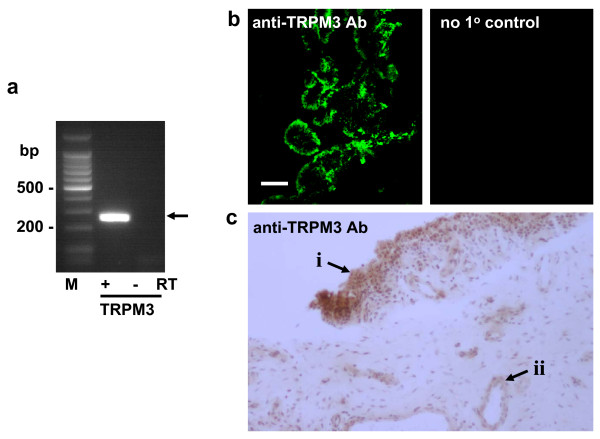
Expression of TRPM3 in FLSs of synovium in rheumatoid arthritis. (a) PCR products from analysis of mRNA isolated from primary cultured FLSs from patients with (+) and without (-) prior reaction with reverse transcriptase (RT). On the left is the DNA marker ladder (M). The expected TRPM3 mRNA product size is indicated with an arrow. (b) Serial sections of RA synovial biopsy labeled with the primary (1°) anti-TRPM3 antiserum present (left image) or absent (right image). Positive labeling is green. The scale bar is 50 μm. (c) A section of RA synovial biopsy labeled with anti-TRPM3 antiserum (brown) and counter stained with haematoxylin to label cell nuclei (purple). The lining of the synovium (i) and a blood vessel (ii) are indicated by arrows.